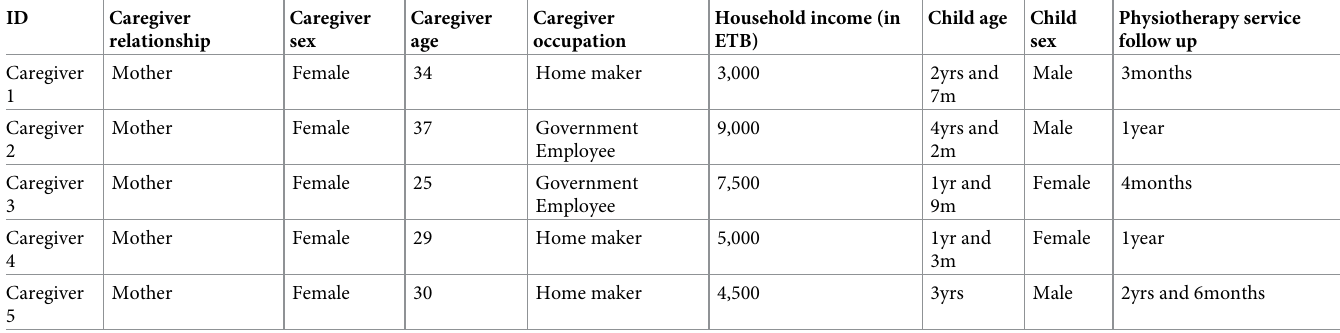
Table 1. Sociodemographic factors of caregivers of CP